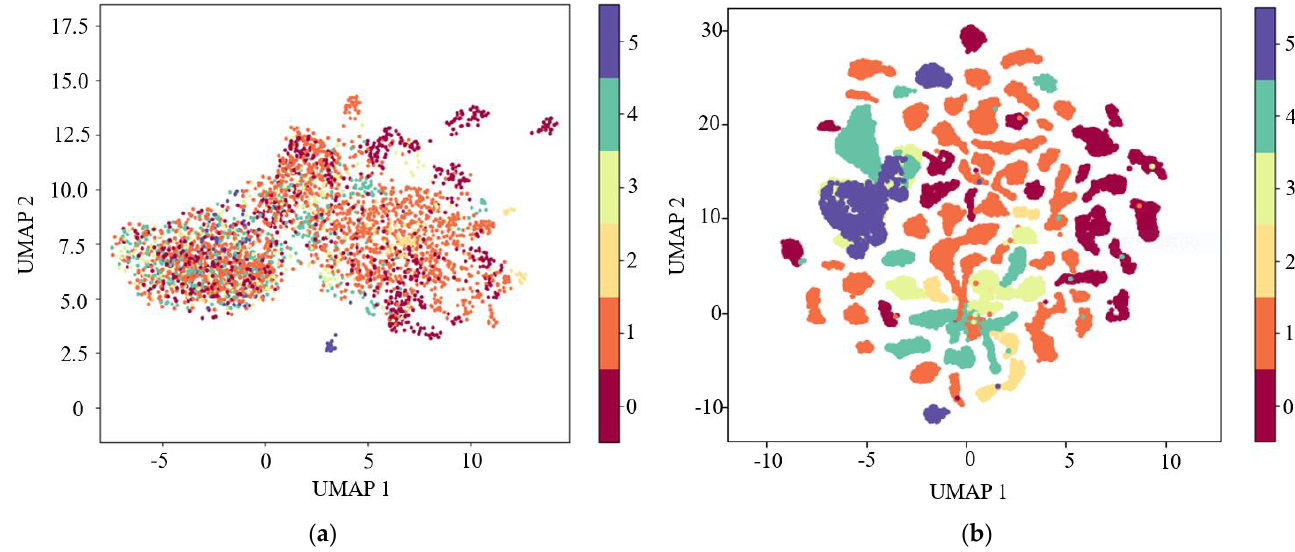
Figure 6. Segmentation of the raw data of the UMAP regions: ( a ) raw data, ( b ) the data extracted from the final layer output, where 0 – 5 represent the urinary pattern label.